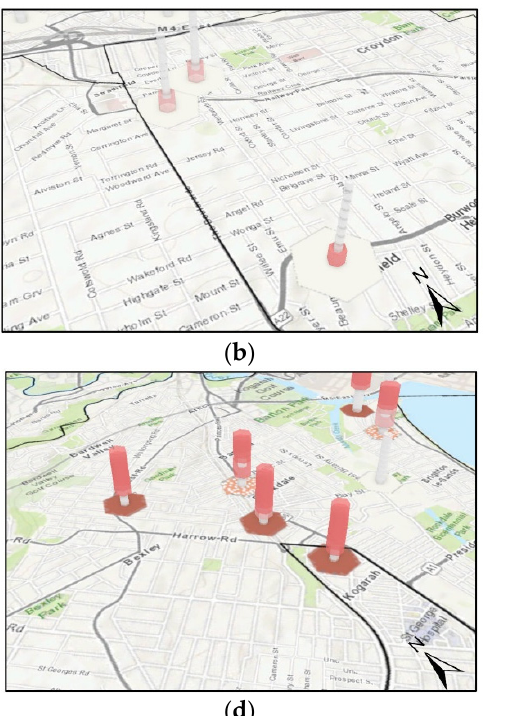
Figure 18. ( a ) Limited ‐ licence spatio ‐ temporal analysis 2012–2021; ( b ) Limited ‐ licence space ‐ time cube 3D visualisation northern section; ( c ) Limited ‐ licence space ‐ time cube 3D visualisation south ‐ western section (1); ( d ) Limited ‐ licence space ‐ time cube 3D visualisation south ‐ western section (2).